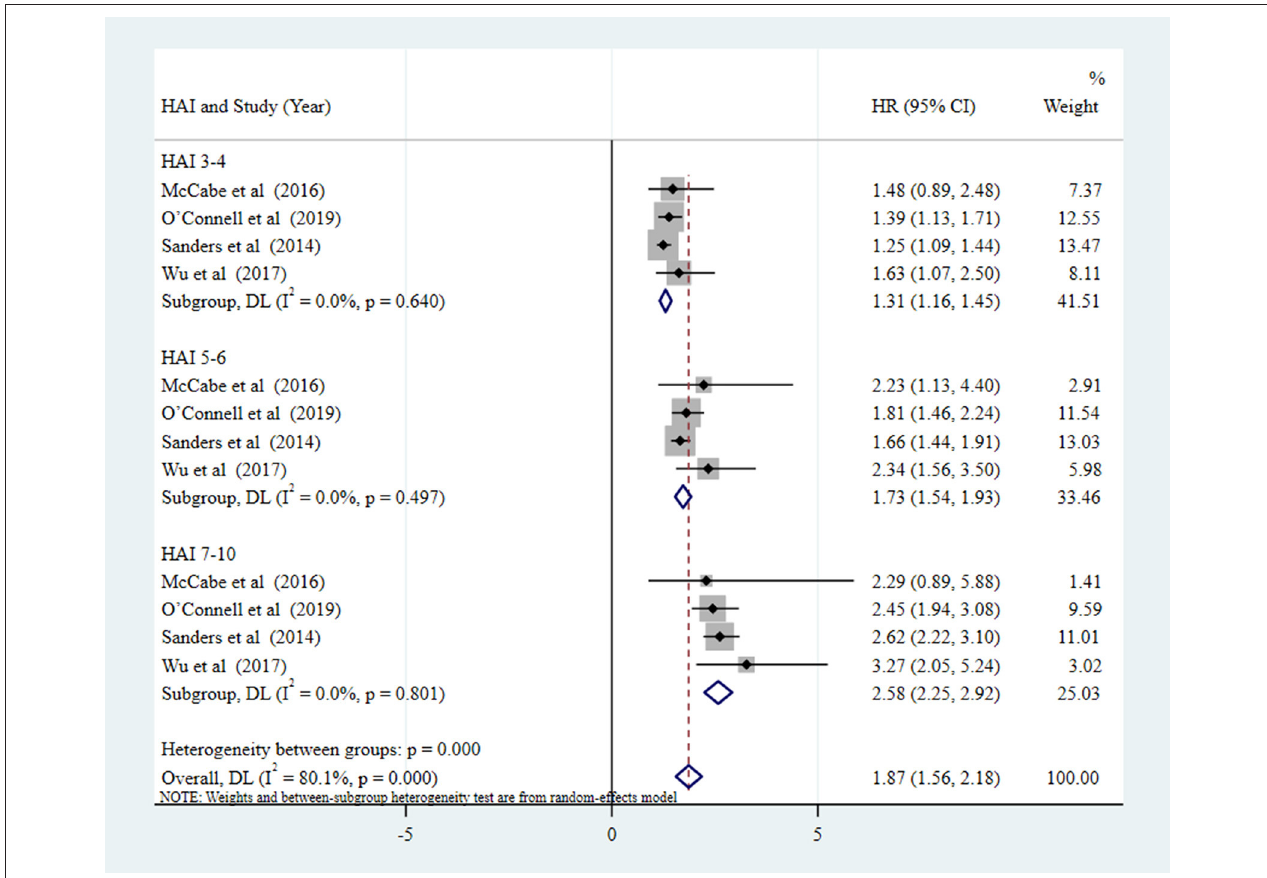
FIGURE 4 | Forest plot of the pooled HR of all-cause mortality risk for SA (SA as four-category variable, measured by HAI: HAI 0-2 [healthy], HAI 3-4, HAI 5-6, HAI 7-10 [unhealthy], respectively. HAI 0-2 as the reference group).